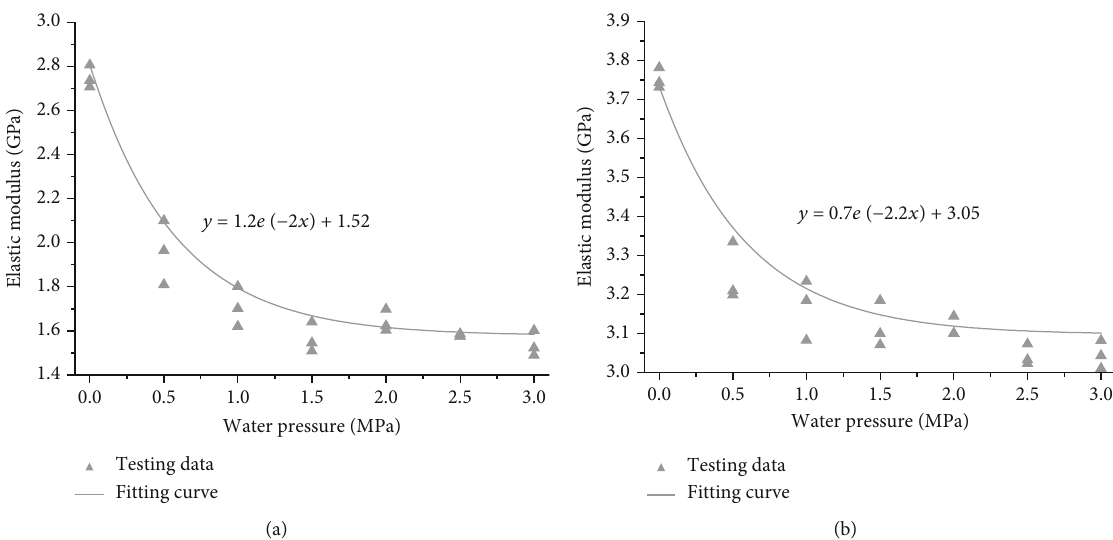
Figure 1: The elastic modulus changes with water injection ((a) coal samples from the Pingdingshan No. 10 coal mine; (b) coal samples from the Gushuyuan coal